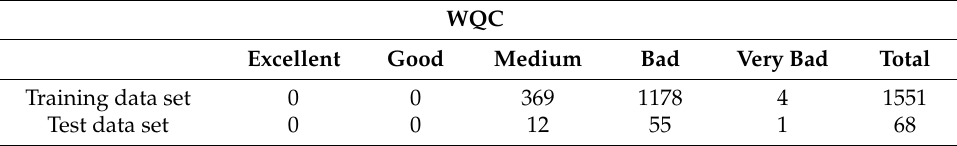
Table 3. WQC observed within the training and testing data